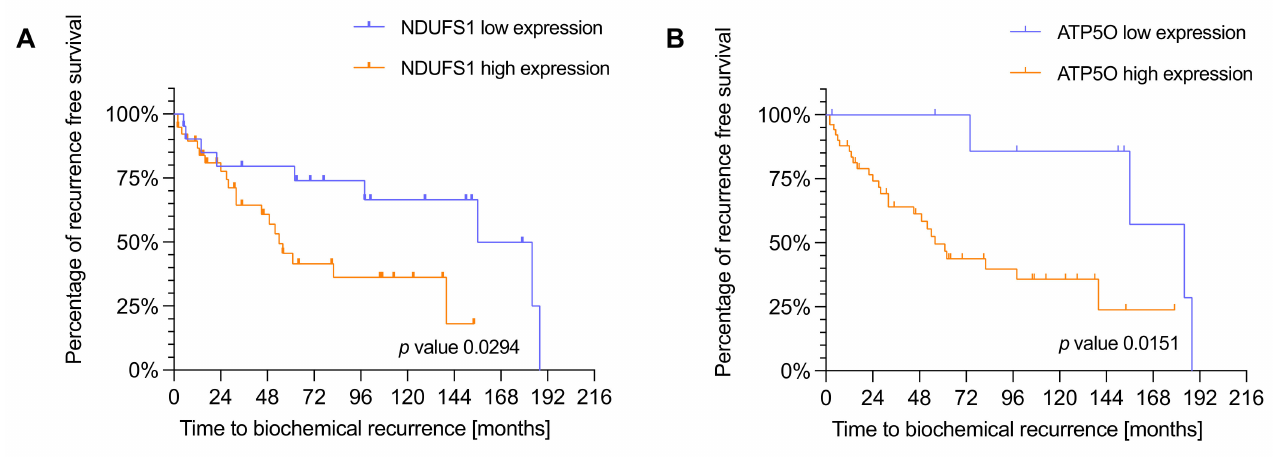
Figure 4. ( A ) Kaplan-Meier plot showing time to biochemical recurrence in months for NDUFS1 in the IHC cohort ( n = 60). p -values were estimated by log-rank test. Hazard ratio of 2.188 with a confidence interval of 1.056 to 4.530. Blue = low expression, orange = high expression. ( B ) Kaplan-Meier plot showing time to biochemical recurrence in months for ATP5O in the IHC cohort ( n = 61). p -values were estimated by log-rank test. Hazard ratio of 2.953 with a confidence interval of 1.364 to 6.391. Blue = low expression, orange = high